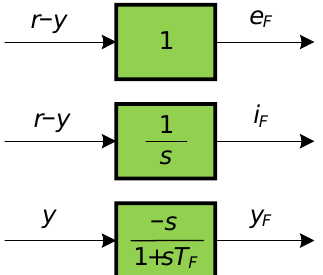
Figure 4. Filtering process input ( u ) and output ( y ) signals to obtain the regression signals e F , i F and y F , where r = K PR u.